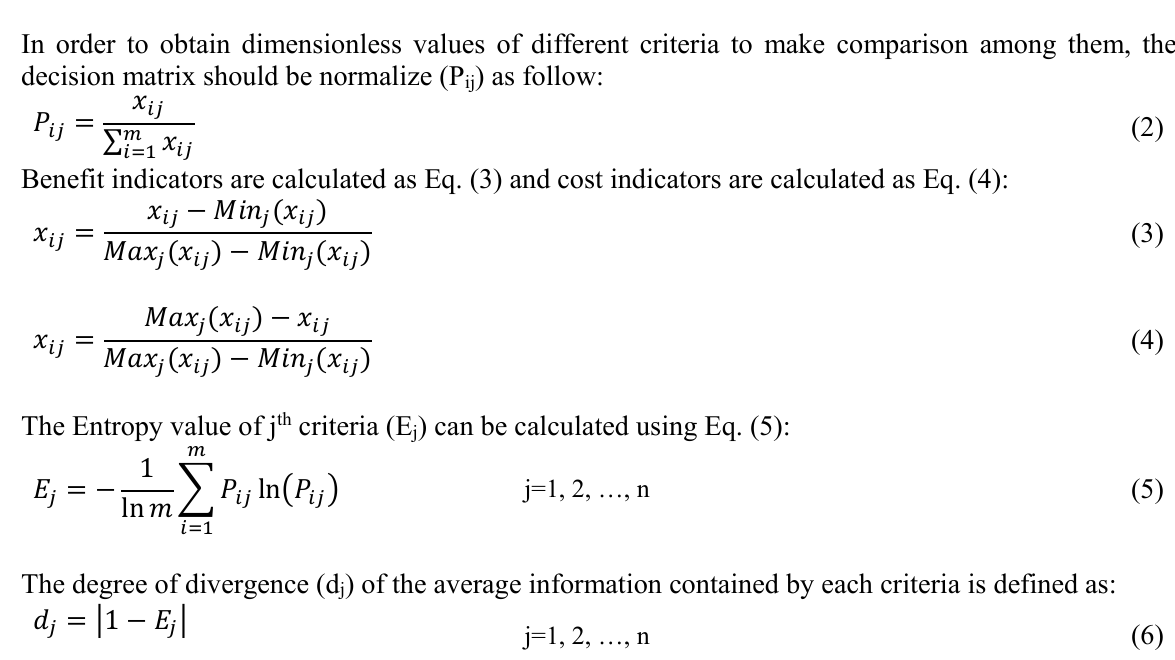
Experiments using Taguchi L9 orthogonal array and the results (decision matrix table) Alternative LDR